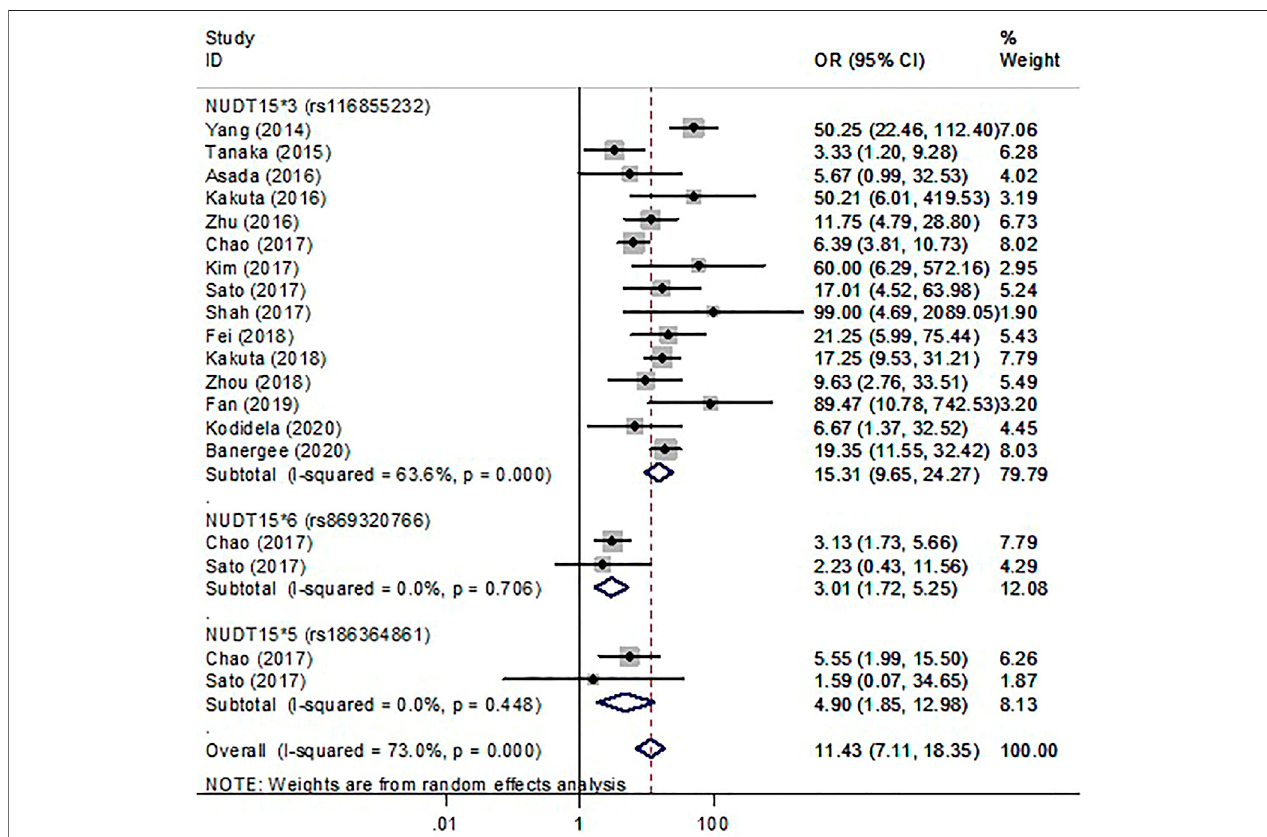
FIGURE 2 | The forest plots for the association of NUDT15 variants with thiopurine-induced early leukopenia. Note: Width of the box indicates the precision of the estimates; diamond, the overall summary estimate for the analysis (width of the diamond represents the 95% CI) .